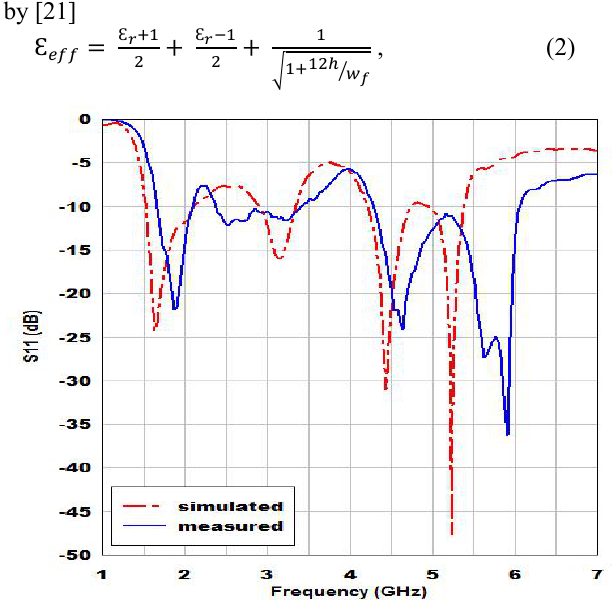
Figure 7: The s imulated and measured input reflection coefficient of the designed slot